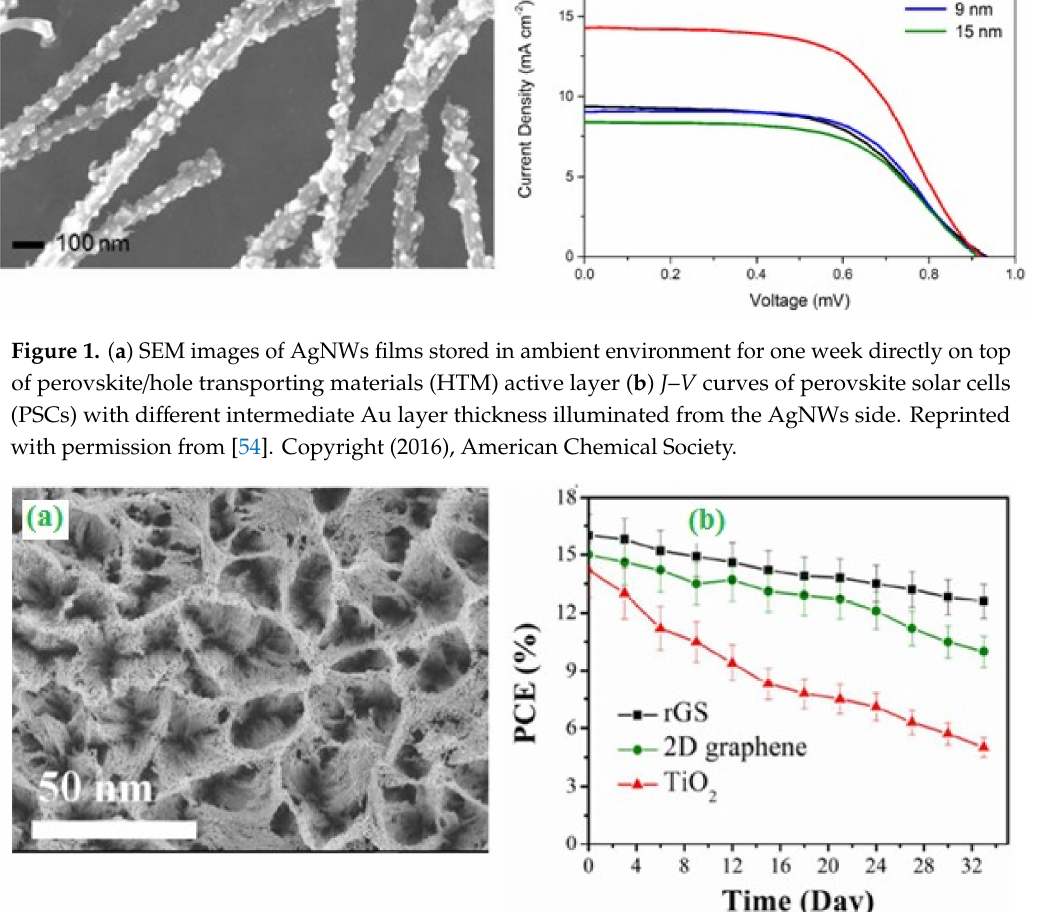
Figure 2. ( a ) SEM image of the reduced graphene sca ff old (rGS) structure (Top view) ( b ) Stability of the devices in an ambient environment (~65% humidity) after encapsulation using UV-cured epoxy. Reprinted with permission from [56]. Copyright (2016), American Chemical